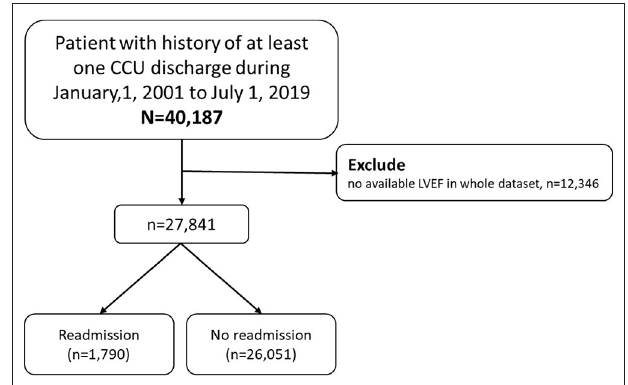
FIGURE 1 | Study design and screening criteria flow chart. CCU, coronary care